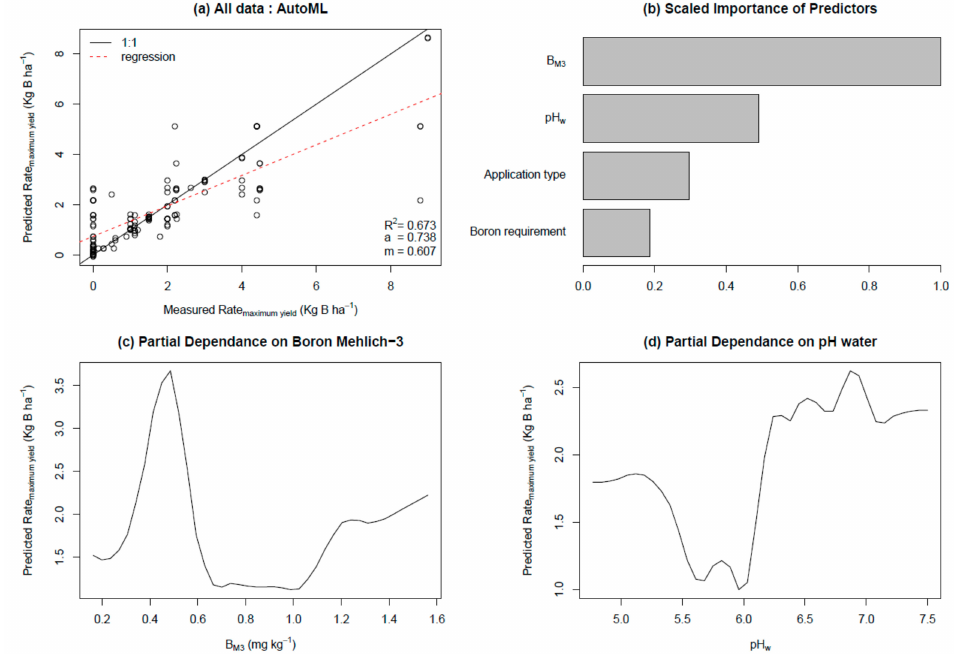
Figure 6. Prediction of rate of born corresponding to maximum yield (Rate Maximum yield ) and statistical analysis. ( a ) Correlation between measured and predicted Rate Maximum yield ; ( b ) scaled importance of predictors (B M3 , pH W , application type, boron requirement); ( c ) partial dependence on B M3 ; ( d ) partial dependence on pH W